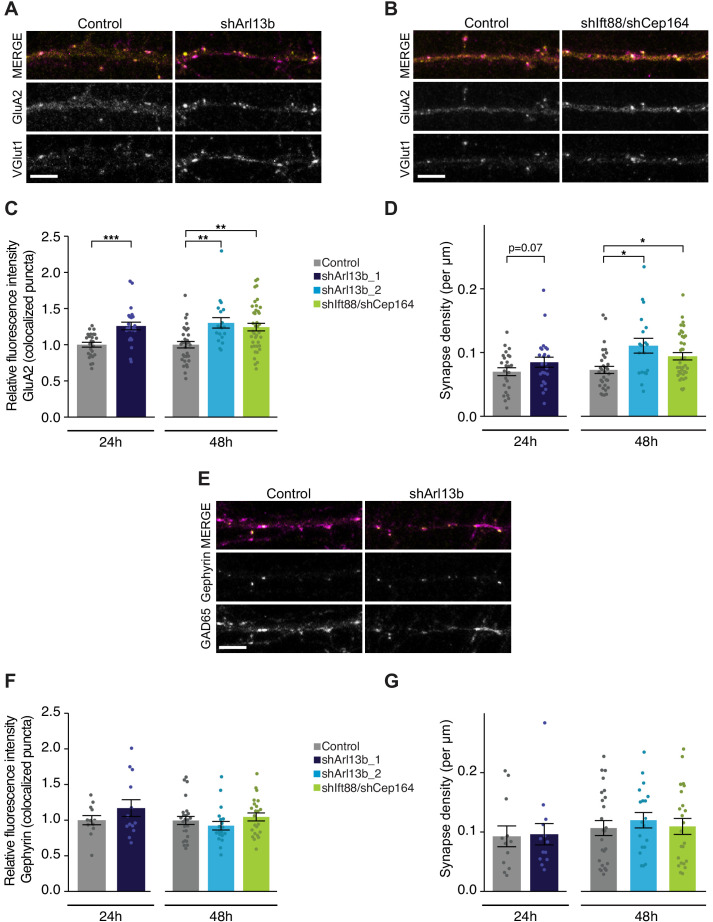
Acute knockdown of ciliary proteins increases the strength and number of excitatory synapses.(A, B, and E) Representative images of pyramidal neuron dendrites immunolabeled with antibodies against GluA2 and VGlut1 (A and B), or Gephyrin and GAD65 (E). Cultures were transfected with GFP alone or together with the indicated plasmids. Scale bars: 5 μm. (C) Relative fluorescence intensity of immunolabeled GluA2 at GluA2 /VGlut1 colocalized puncta for indicated conditions at 24 hr or 48 hr following transfection. Intensity values are normalized to controls. Each dot is the average summed pixel value for all measured synapses from a given neuron. Bars are average ± SEM. ** and *** indicate p<0.01 and 0.001, respectively, for the indicated conditions (LMM with Dunnett-type correction for multiple comparisons). n: Control = 25 (24 hr) and 32 (48 hr), shArl13b_1 = 24, shArl13b_2 = 19, shIft88/shCep164 = 39; four dissociations. (D) Number of colocalized GluA2/VGlut1 puncta per μm of dendrite analyzed (density) onto neurons transfected with the indicated plasmids at 24 hr or 48 hr following transfection. Each dot is the density of synapses examined per neuron. Bars are average ± SEM. * indicates p<0.05 for the indicated conditions (LMM with Dunnett-type correction for multiple comparisons); additional p-values are also indicated. n: As in C. (F) Relative fluorescence intensity of immunolabeled Gephyrin at colocalized puncta on neurons transfected with the indicated plasmids at 24 hr or 48 hr following transfection. Intensity values are normalized to values in control neurons. Each dot is the average summed pixel value for all measured synapses from a given neuron. Bars are average ± SEM. n: Control = 17 (24 hr), shArl13b_1 = 22 neurons; four dissociations; and Control = 25 (48 hr), shArl13b_2 = 19, shIft88/shCep164 = 23; three dissociations. (G) Number of colocalized Gephryin/GAD65 puncta per μm of dendrite analyzed (density) onto neurons transfected with the indicated plasmids at 24 hr or 48 hr following transfection. Each dot is the density of synapses examined per neuron. Bars are average ± SEM. n: As in F. Also see Figure 2—figure supplement 1.
Figure 2—source data 1.Source data for Figure 2.